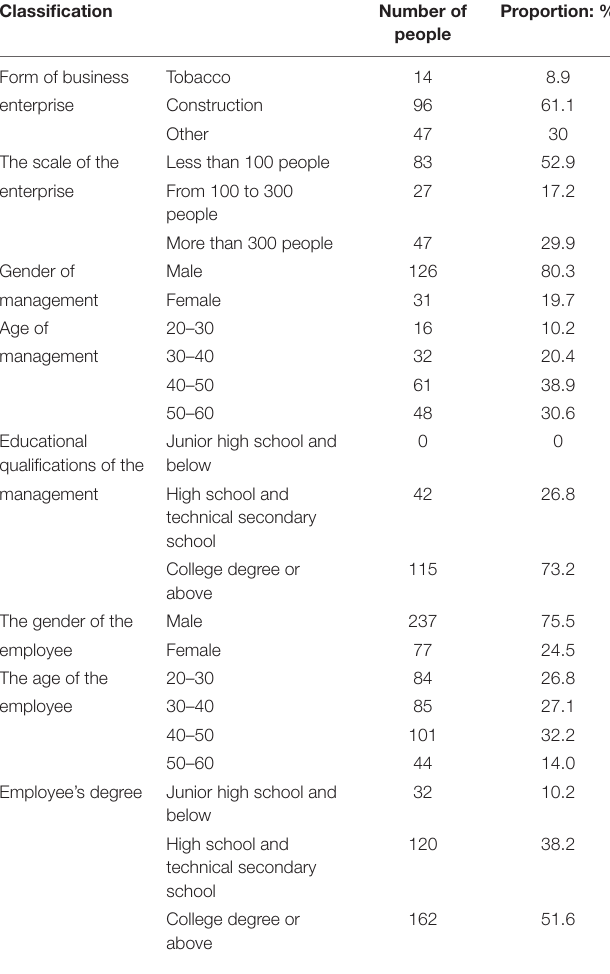
TABLE 1 | Descriptive statistics of demographic